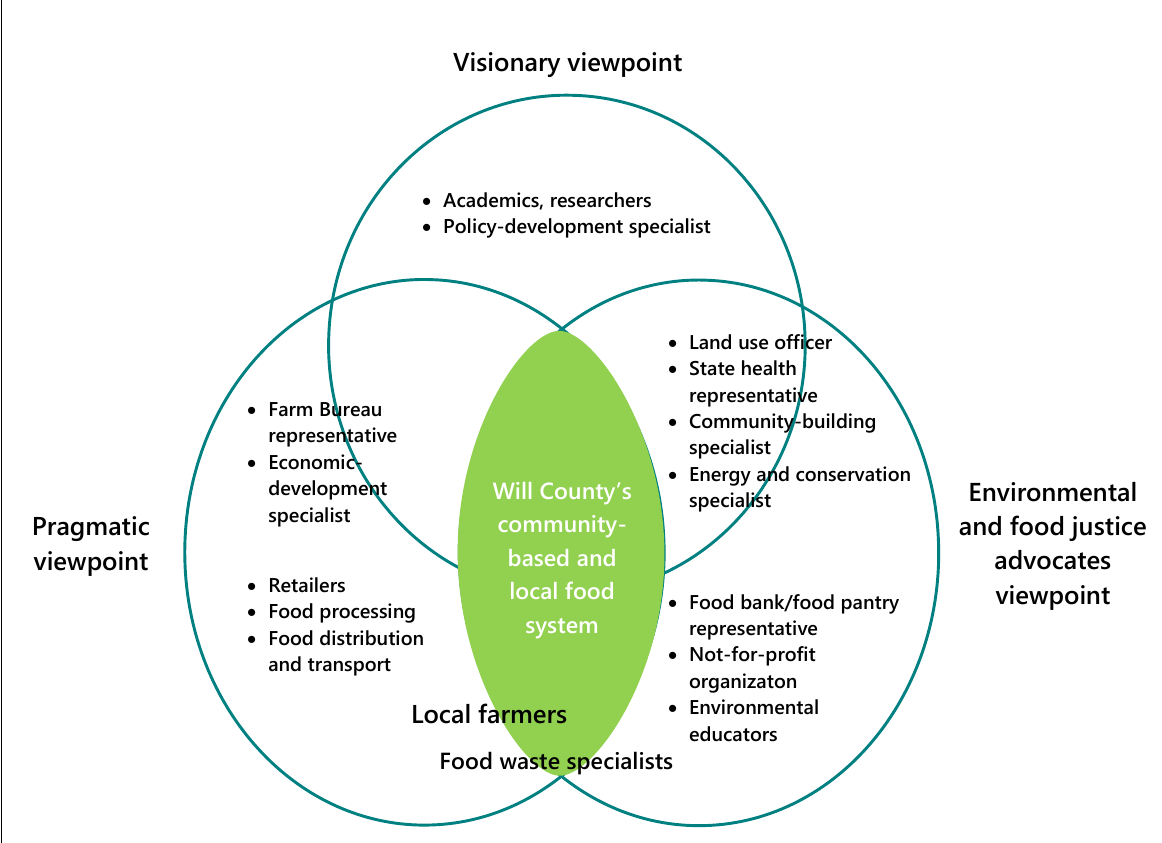
Figure 2. Stakeholders Categorized According to their